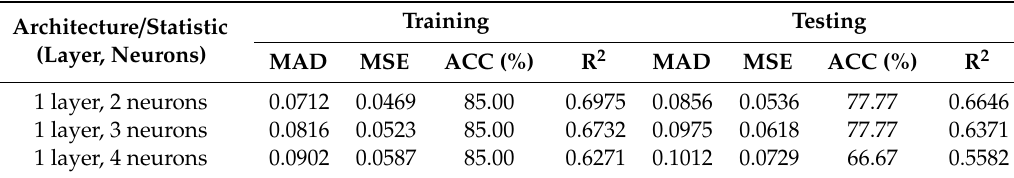
Table 6. Goodness-of-fit statistics for artificial neural network (ANN) architectures.